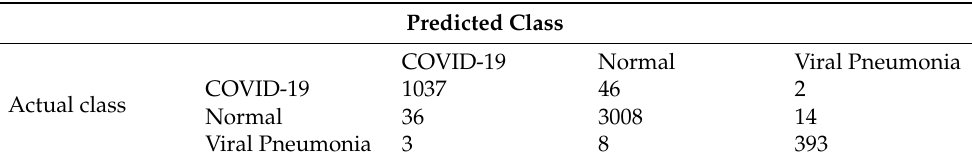
Table 4. Confusion matrix of the proposed CovidDetNet